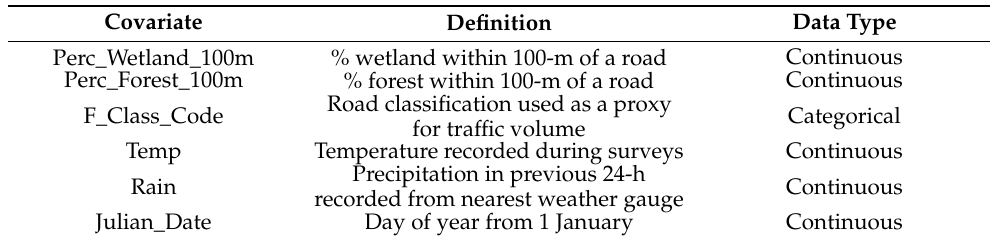
Table 1. Covariates used in model development to assess occupancy and detection probability of road mortality hotspots in Rhode Island, 2019–2021.